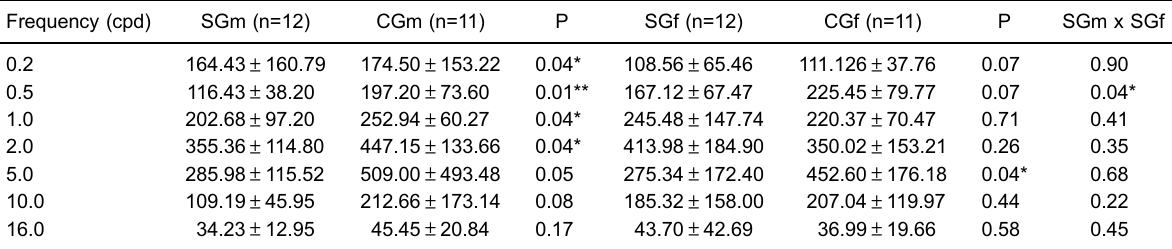
Table 3. Visual contrast sensitivity function scores by spatial frequency in cpd and by group (exposed and unexposed women or exposed and unexposed men). Frequency (cpd)